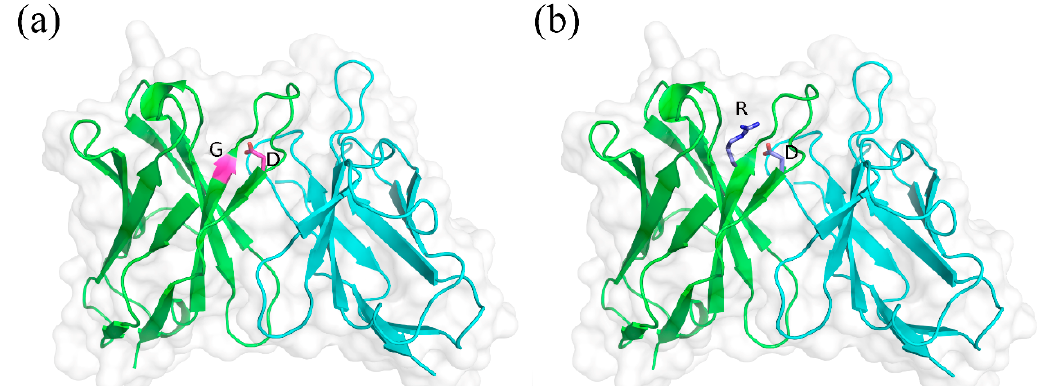
Figure 9. Structural modeling analysis on the mechanism of the improved stability of G94R antibody. Structures of the wild-type and G94R mutant were constructed and modeled by using ABodyBuilder and CISRR programs (Refer to Materials and methods). ( a ) Gly at 94 and Asp at 100 A are shown in purple sticks. ( b ) Arg at 94 an Asp at 100 A are shown in blue sticks. The salt-bridge formed between the two residues, which stabilizes the loop structure of CDR3.